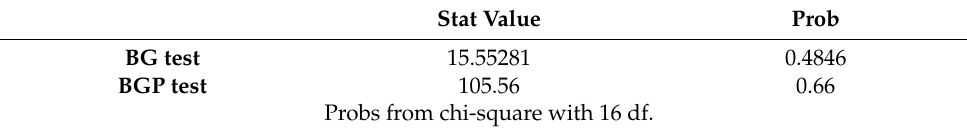
Table 6. Residual Statistics.